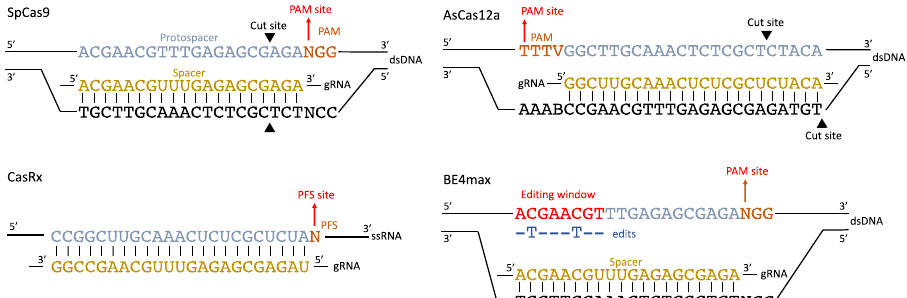
Fig. 1 | Examples of DNA- and RNA-targeting nucleases represented in crispr- Base . gRNA spacer sequences are shown in yellow. Target DNA/RNA protospacer sequencesareshowninblue.Protospaceradjacentmotifs(PAMs)andprotospacer fl anking sequences (PFSs) are shown in orange. Nuclease-speci fi c cutting sites are